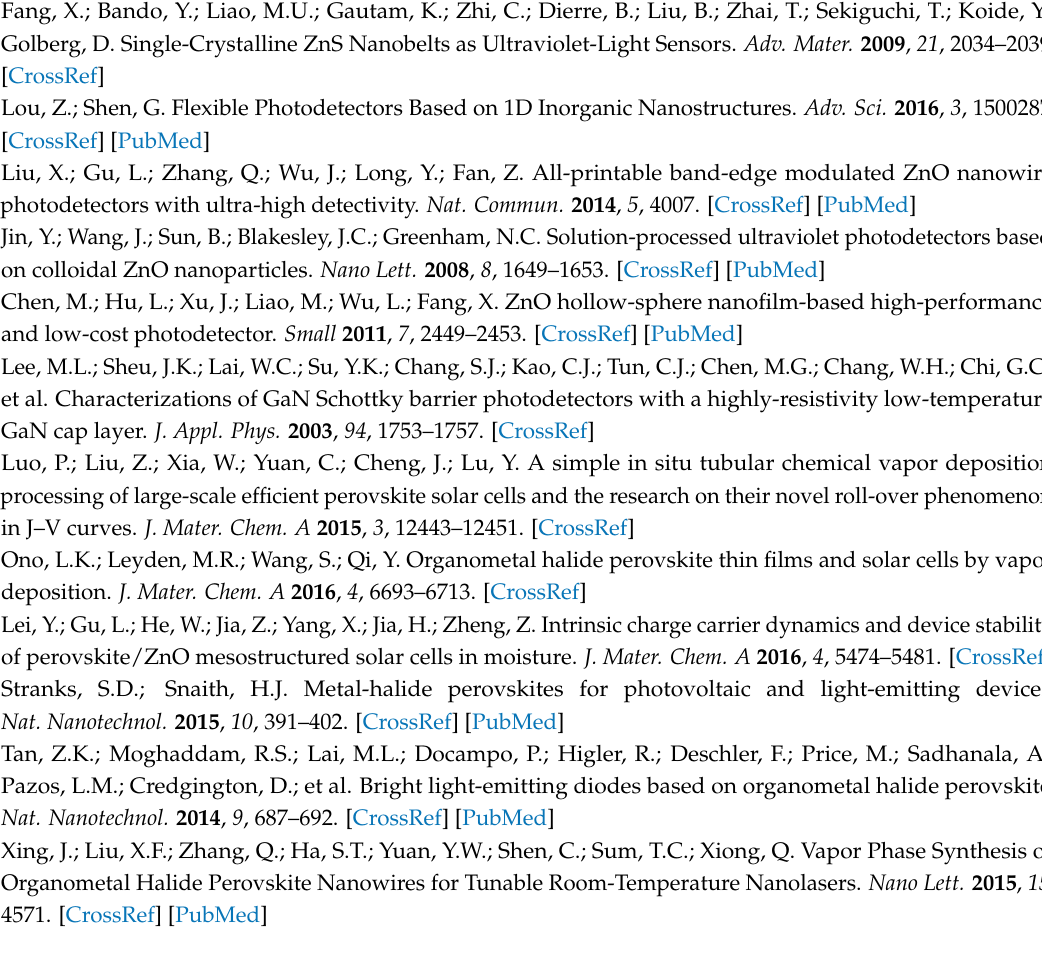
Figure S1: SEM images of perovskite MAPbI3 nanowires formed by self-assembly particles, Figure S2: SEM images of perovskite MAPbI3 nanowires with DMF volume of (a) 15 µ L, (b) 10 µ L, (c) 5 µ L, Figure S3: SEM images of perovskite MAPbI3 nanowires with MAI concentration in IPA (a) 12.5 mg/5 mL, (b) 22.5 mg/5 mL, (c) 27.5 mg/5 mL, (d) 37.5 mg/5 mg, Figure S4: The I-t curves of devices fabricated under Ar and tested in inner